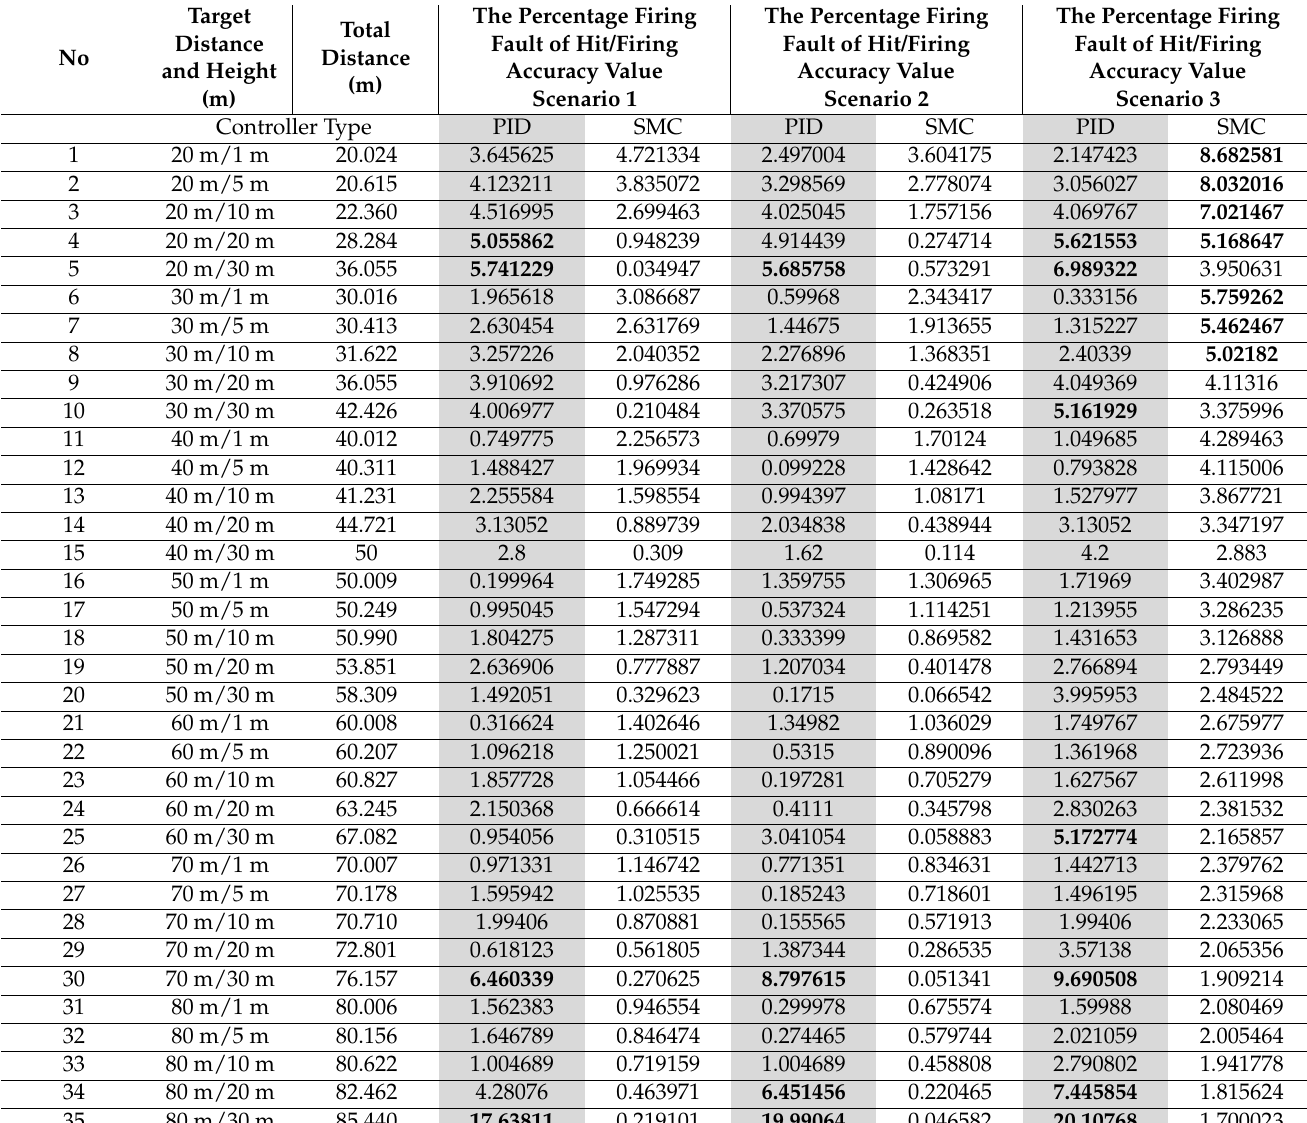
Table 10. Shooting performance for all